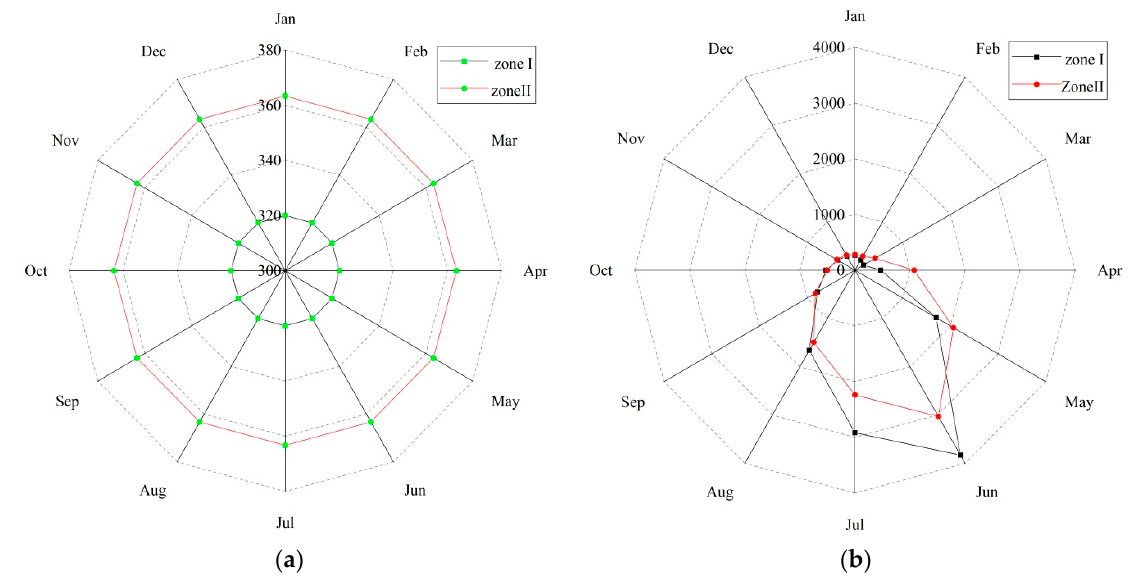
Figure 20. Fixed and monthly threshold levels for both zones. ( a ) Fixed ( b ) monthly threshold levels